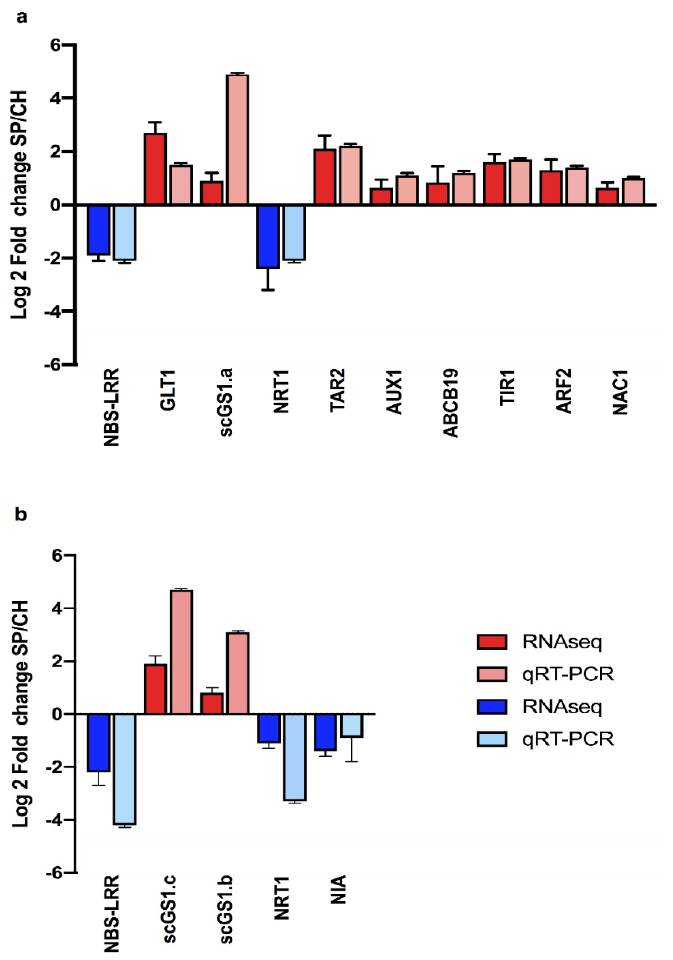
Figure 4. Validation of RNA-seq results by qRT-PCR analysis. Patterns of expression of genes were analyzed in roots ( a ) and ( b ) shoots of the two contrasting BNF-genotypes. Comparison of the pattern of expression of DETs between SP and CH in stalk tissues, showing log2 values in the transcriptome libraries and the qRT-PCR analyses. For the expression in the transcriptome libraries, results are presented as the ratio SP/CH of the RPKM of each transcript. Bars represent mean ± standard deviation of the relative mRNA expression in two biological replicates. For the qRT-PCR data, results are presented as the ratio of expression of each transcript (relative to GAPDH and 28S rRNA) in each sample. Bars represent mean ± standard deviation of the relative mRNA expression in three biological replicates (three plants) and each biological replicate analyzed with three technical